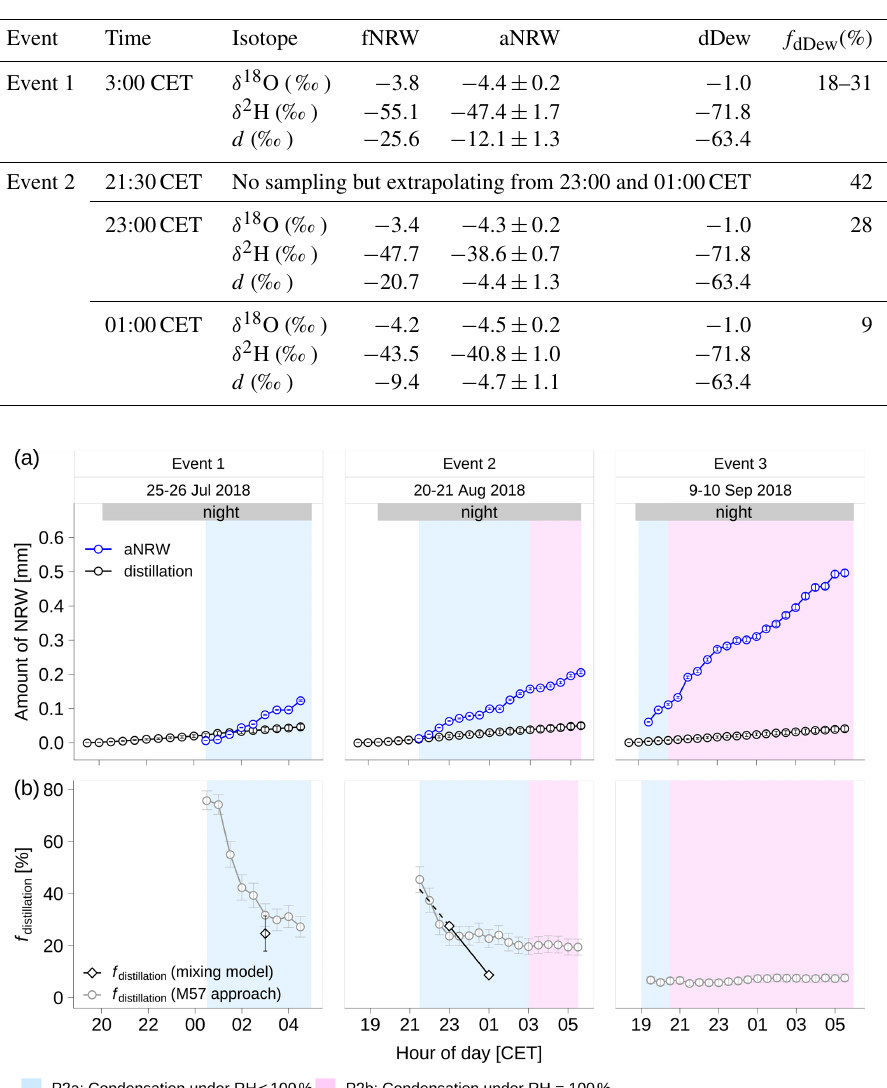
Figure 10. Computed amounts of non-rainfall water (NRW) and the contribution of distillation ( f distillation ) in the total NRW on foliage (fNRW): (a) computed amount of NRW condensing from ambient water vapor (aNRW) and computed amount of distillation using the M57 approach. (b) Ratio of distillation f distillation in NRW on foliage computed from the two-end-member mixing model (black) and the ratio of distillation f distillation in total NRW using the M57 approach as described in Sect. 3.2.5 (grey). The P2a period was the dew formation period in the conditions of relative humidity < 100%; the P2b period was the combined dew and radiation fog period in the conditions of relative humidity =